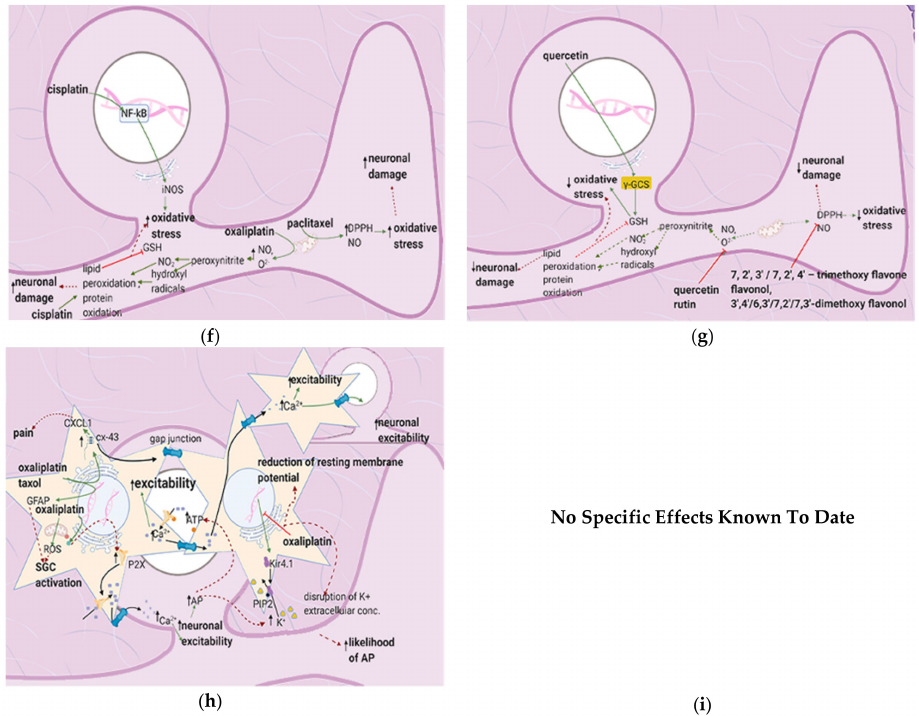
Figure 4. The actions of anticancer drugs (left column) and flavonoids (right column) on a dorsal root ganglion. ( a ) Simplified Overview. Flavonoids counteract anticancer drugs and increase mito- chondrial damage, proinflammatory cytokine production, receptor sensitization, and the likelihood of an action potential. Also depicted is how anticancer drugs increase satellite glial cell coupling and excitability. ( b ) Anticancer Drugs on Proinflammatory Cytokine Production at the DRG. Anticancer drugs increase the translation of proinflammatory cytokines, prostaglandins, and NO through SIRT1 pathway downregulation and NF- κ B activation. This leads to receptor sensitization and an increased likelihood of an action potential firing; ( c ) Flavonoids on Anticancer Drug- Induced Proinflammatory Cytokine Production in the DRG. Flavonoids counteract anticancer drugs’ actions at the DRG by inhibiting the translocation of NF- κ B, upregulating the SIRT1 pathway, and inhibiting the produc- tion of proinflammatory cytokines and prostaglandins. These actions decrease inflammation and consequently decrease the likelihood of AP firing and receptor sensitization; ( d ) Anticancer Drugs on Ion Channels and NT Production at the DRG. Anticancer drugs increase the expression of ion channels such as TRPV1 and N-type VGCC, increasing intracellular Ca 2+ concentrations and con- sequently increasing NT release. It also results in a dorsal root reflex; ( e ) Flavonoids on Anticancer Drug-Induced Increases in NT Production and Ion Channel Expression. 6-MeOF triggers GABAA receptors, decreasing an AP’s likelihood and consequently reducing NT release and alleviating pain; ( f ) Anticancer Drugs on the DRG’s Oxidative Stress Level. Anticancer drugs increase mitochondrial oxidant production, resulting in lipid peroxidation and tyrosine nitrosylation, lowering GSH levels in the cell and increases oxidative stress, causing neuronal damage; ( g ) Flavonoids on Anticancer Drug- Induced Increases in DRG Oxidative Stress. Flavonoids counteract the increase in oxidative stress by increasing the translation of GSH and directly scavenging reactive oxygen species; ( h ) Anticancer Drugs on Satellite Glial Cells. Anticancer drugs increase the expression of gap junctions that connect astrocytes surrounding the same and different DRGs. They also connect SGCs and neurons. Ca 2+ waves travel through these gap junctions, reducing the membrane potential of SGCs and increasing the likelihood of AP firing in neurons. The Ca 2+ waves are hypothetically generated by the anticancer drug-induced increase in P2X levels following inflammation. Oxaliplatin blocks the production of Kir4.1, disrupting the extracellular concentration of K + and leading to an increased likelihood of an AP; ( i ) Flavonoids on Anticancer Drug Effects in Satellite Glial Cells. No relevant research was found on how flavonoids counteract anticancer drug effects on